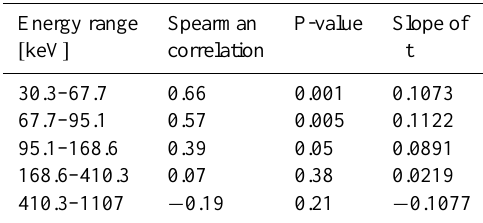
Table 3. Spearman correlation coefficients between differential pro- ton fluxes in the exterior cusp and magnitude of IMF B y in different energy